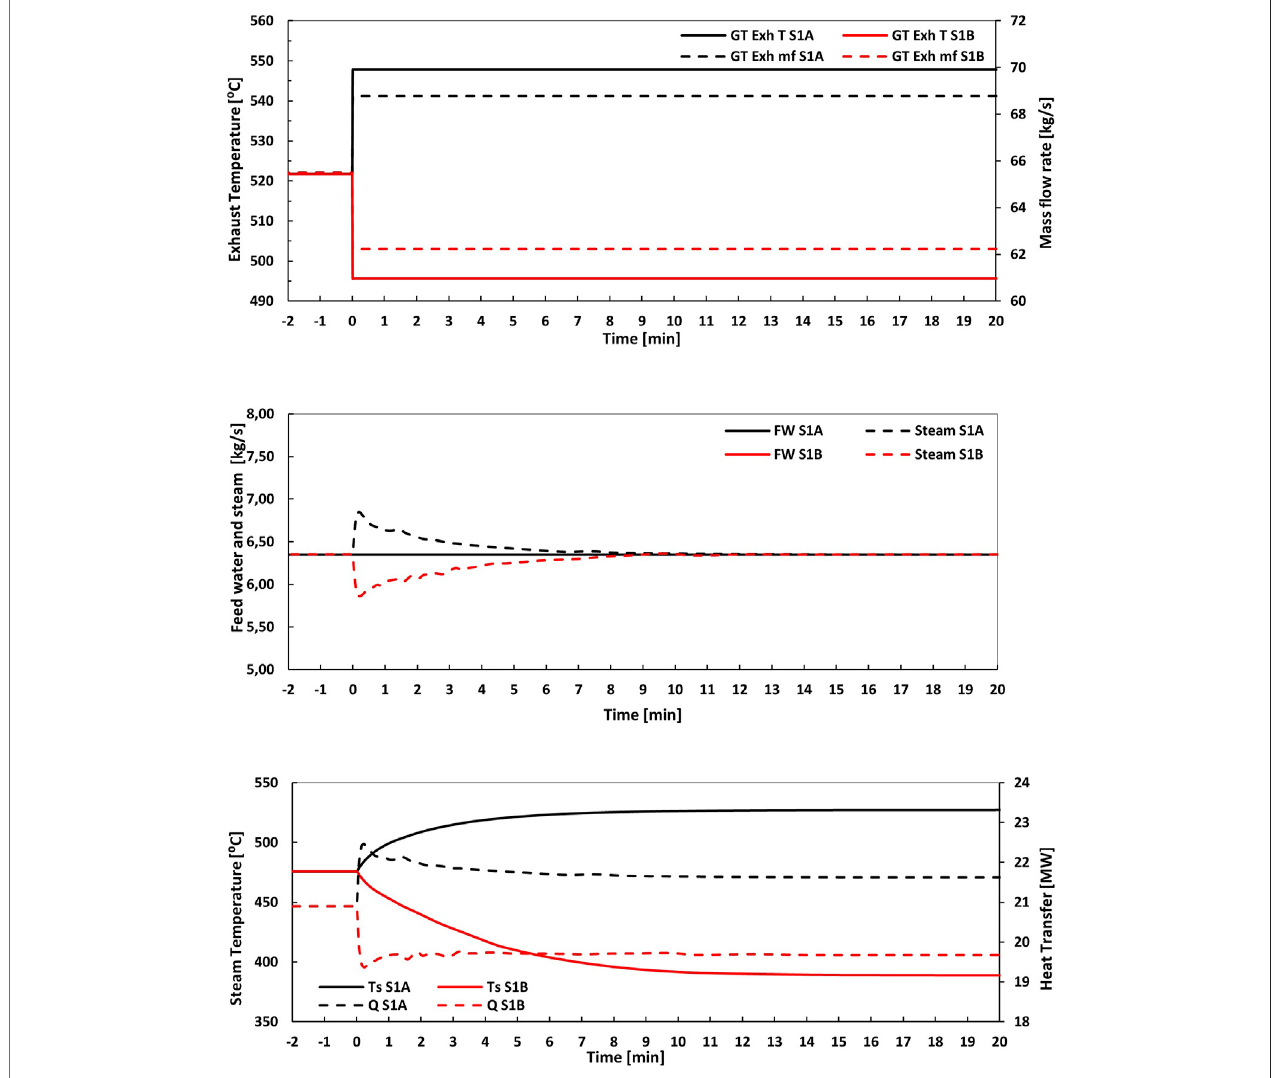
FIGURE8| Dynamic simulation results forScenario1.Theprocess variables shown are (A) exhaustgasmass fl owrateand temperature; (B) feedwatermass fl ow rate FW and live steam mass fl ow rate Steam ; and (C) live steam temperature Ts and total heat transfer Q in OTSG.